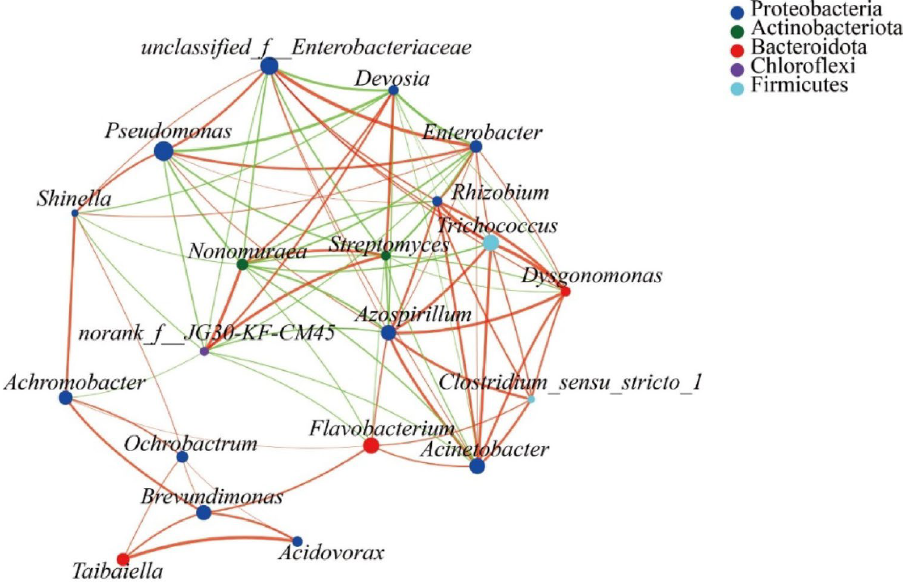
Figure 9. Correlation network diagram on genus level. The green line shows positive correlation, the red line shows negative correlation. The thickness of the line represents the size of the correlation